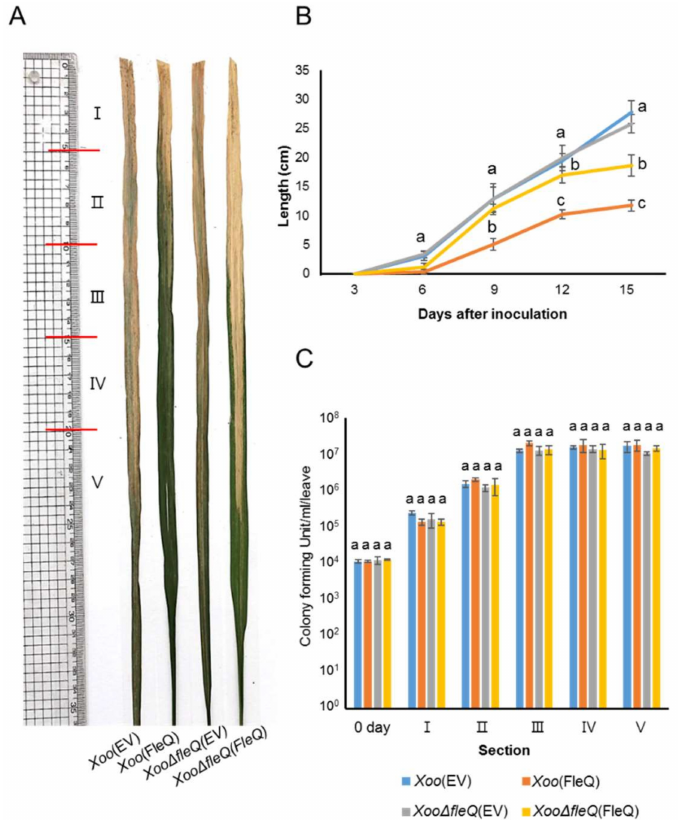
Figure 2. Virulence assay of Xoo (EV), Xoo (FleQ), Xoo ∆ fleQ (EV) and Xoo ∆ fleQ (FleQ) strains on rice plants. ( A ) Representative photograph of leaves taken at 15 days after inoculation (DAI). ( B ) Graph represents lesion length which was measured at 3, 6, 9, 12, and 15 DAI. ( C ) Bacterial populations were calculated at day 0 from whole leaves and 15 DAI from sections. Diseased leaves were divided into 5 cm sections up to 20 cm, and above 20 cm to the end. Bars indicate the mean of at least six leaves with the standard deviations. Different letters on the bars indicate statistically significant differences in average values by one-way ANOVA ( p <